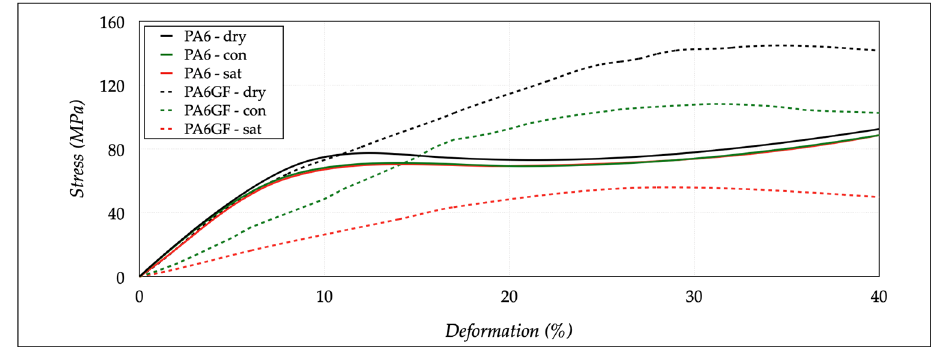
Table 7. Results of compression tests on dry, conditioned (con), and saturated (sat) specimens.